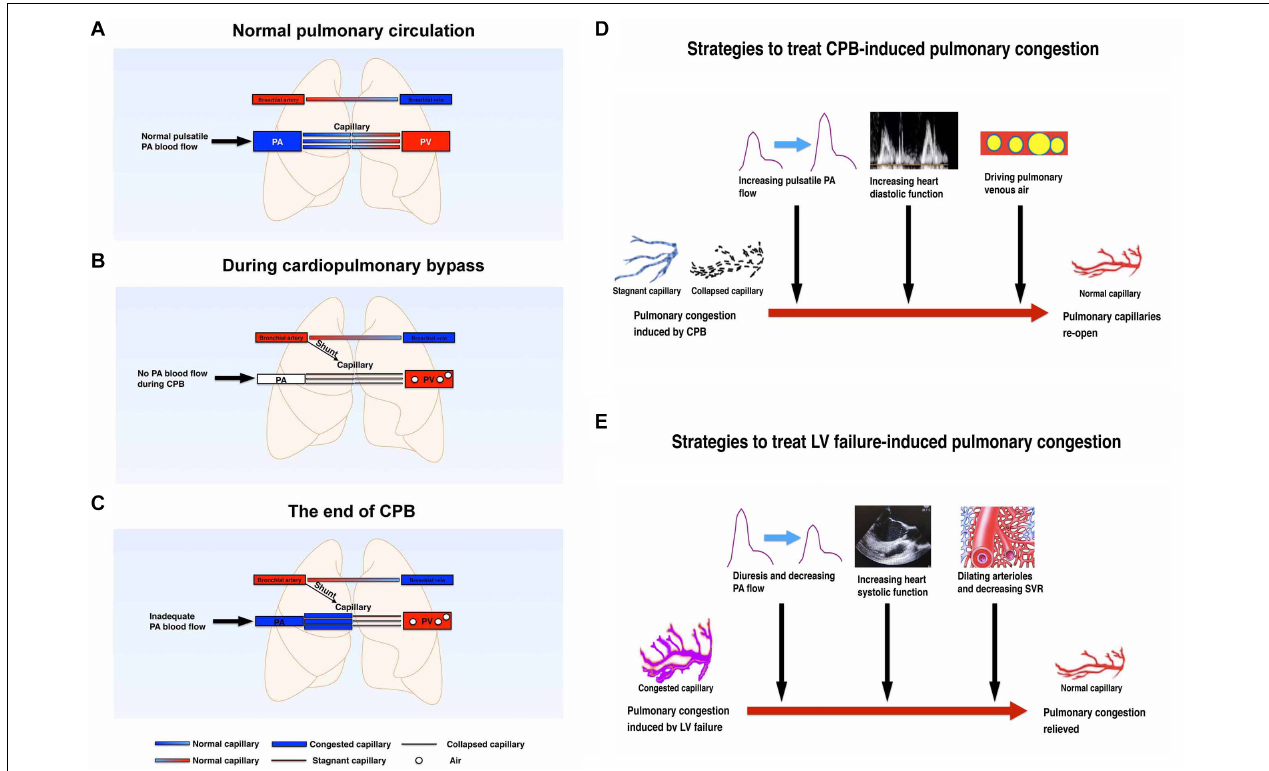
FIGURE 1 | (A) Schematic diagram of pulmonary circulation in the normal physiological state without cardiopulmonary bypass. Both lungs are perfused by the pulmonary artery and bronchial arteries. The blood will be oxygenated in the pulmonary capillaries and returned to the left atrium thought pulmonary vein. (B) Schematic diagram of pulmonary circulation at the beginning of cardiopulmonary bypass. During cardiopulmonary bypass, the heart stops beating after clamping the aorta. Both lungs are mainly perfused with non-pulsatile bronchial arteries. No blood flows through the pulmonary artery. Some of the pulmonary capillaries will be stagnant or collapsed without normal pulsatile pulmonary blood flow. (C) Schematic diagram of pulmonary circulation at the end of cardiopulmonary bypass. After releasing the aortic clamp, some of the pulmonary vessels will be congested because of the following factors: (1) an increase of pulmonary artery flow; (2) capillary flow stagnant and capillary collapse; (3) post-capillary venous air; (4) left atrial diastolic dysfunction. (D) Schematic diagram of the strategies to treat CPB-induced pulmonary congestion. CPB can promote pulmonary capillary congestion which may be induced mainly by collapsed and stagnant pulmonary capillaries. Increasing PA pulsatile blood flow, increasing heart diastolic function, and driving pulmonary venous air can treat this congestion effectively and therefore re-open the pulmonary circulation. (E) Schematic diagram of the strategies to treat LV failure-induced pulmonary congestion. LV failure can suppress pulmonary venous return and promote pulmonary congestion. Diuresis and decreasing PA flow, increasing heart systolic function, and decreasing SVR can effectively treat this congestion. CPB, cardiopulmonary bypass; LV, left ventricle; PA, pulmonary artery; PV, pulmonary vein; SVR, systemic vascular